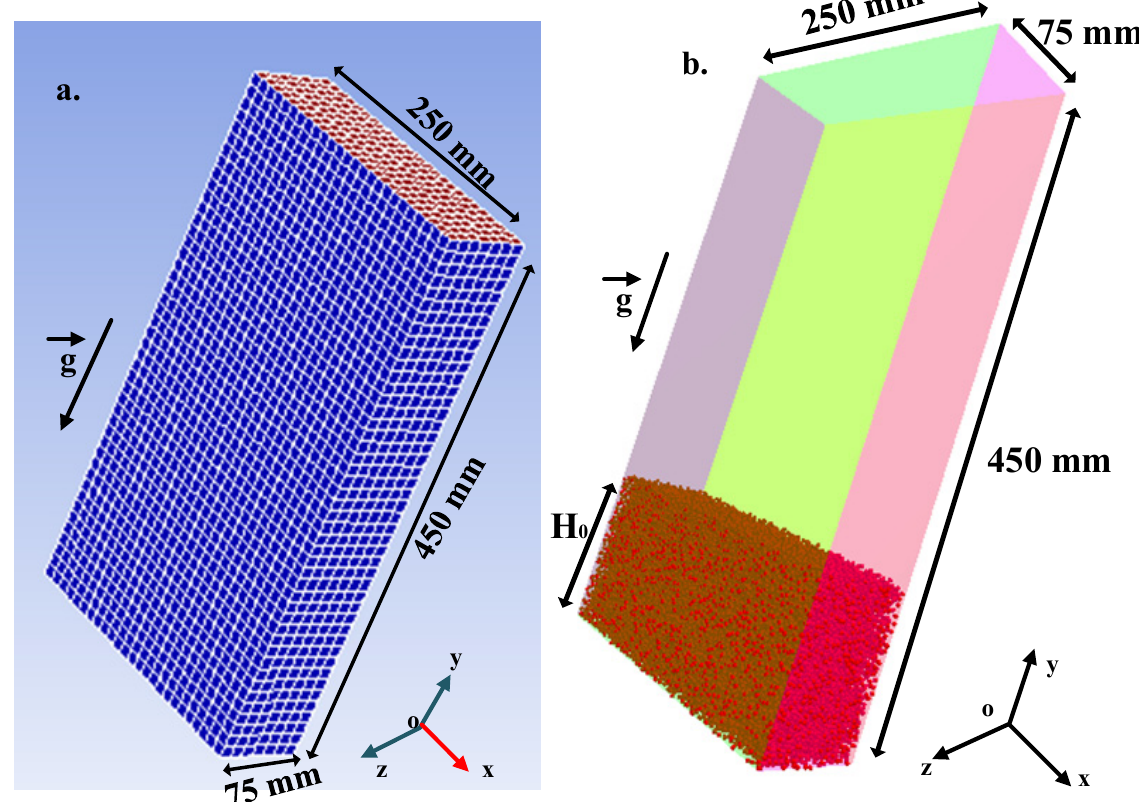
Figure 3. Computational domains: ( a ) ICEM grid; ( b ) simulation domain with EDEM particles.